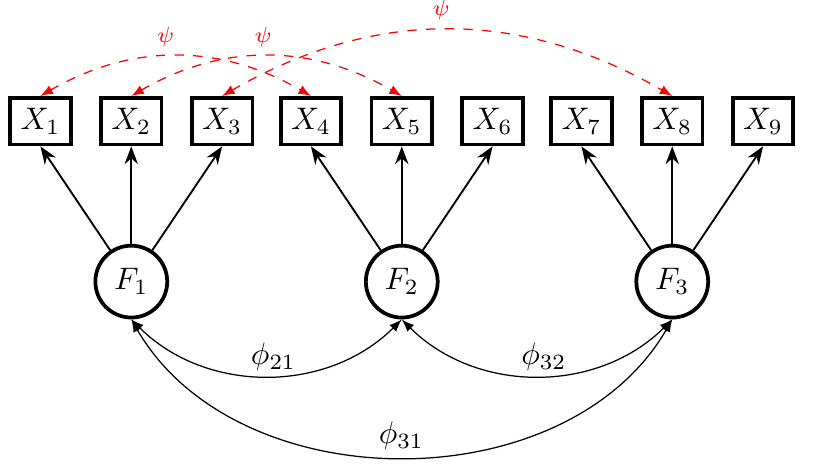
Figure 11. Simulation Study 6: Data-generating model. Residual correlations are displayed with curved dashed red double arrows.